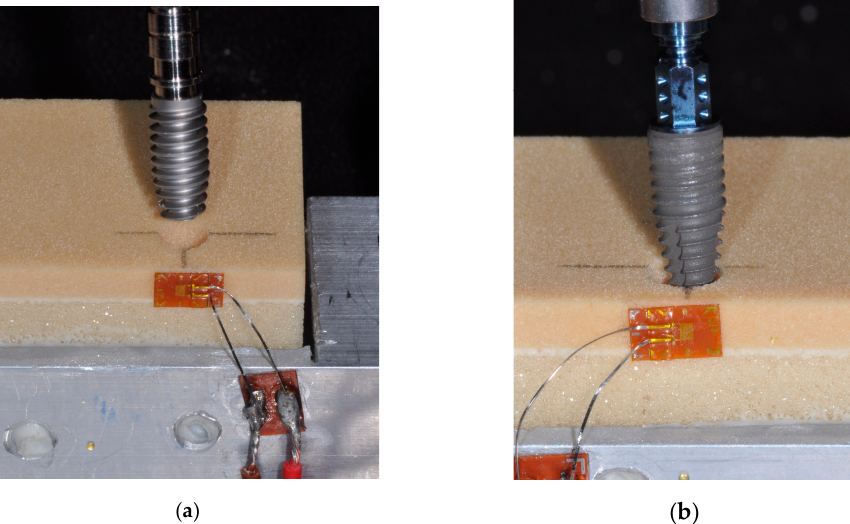
Figure 2. Insertion of a novel design AlfaGate implant ( a ) and a Straumann BLT implant ( b ) into osteotomies created in laminated polyurethane foam simulating alveolar bone. Strain gauges were positioned on the buccal aspect of the bone with the sensing elements oriented in the horizontal direction for recording deformation of the material.